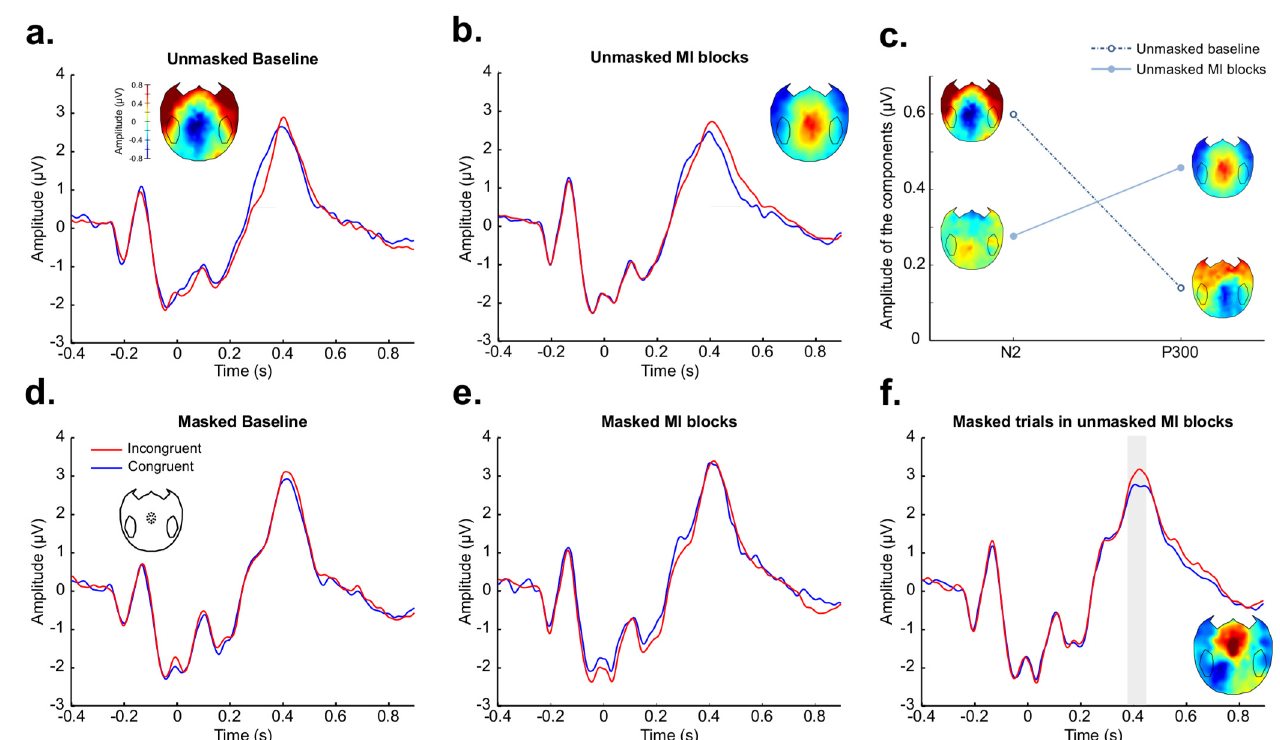
Fig 3. Two ERP components: N2 and P300. In panels(a), (b), (d), (e) and (f), ERP analysesfrom a cluster of 15 electrodesaroundCz in different experimental conditions are presented, with incongruenttrials in red and congruent trials in blue. The gray shadingsindicate time periods of statistical significance(pcorrected < 0.05) and scalp topographies of the difference between incongruent and congruent trials show the effects of congruence duringthese time periods.(a) In the unmasked baseline,the N2 componentis modulated by congruence from 272 ms to 364 ms after the target onset. (b) In unmasked mostly-incongruent (MI) blocks, the P300 componentis modulated by congruencefrom 404 ms to 572 ms after the target onset. (c) The amplitudeof the N2 and P300 components was computedas the absolute value of the difference betweencongruentand incongruent trials in the time windowsof interest for each component. We found a significantinteraction (F(1,19) = 6.67, p = 0.02) betweenthe amplitudeof the componentsand the experimental condition(unmaskedbaseline—dotted line/unmasked mostly-incongruentblocks—continuous line). Scalp topographies of the difference betweenincongruentand congruent trials for the time windowof interest for each componentand in each conditionare plotted next to the corresponding point in the plot. (d) No significantdifference was observedin the EEG betweencongruent and incongruent trials in the masked baselinecondition. (e) No significantdifference was observedin the EEG betweencongruentand incongruent trials in the masked baselinecondition. (f) Interestingly, in the masked trials includedin the unmasked mostly-incongruent blocks, a modulationof the P300 by congruence was observed from 384 ms to 452 ms after the target onset, similar to the signatureobservedfor unmaskedtrials in